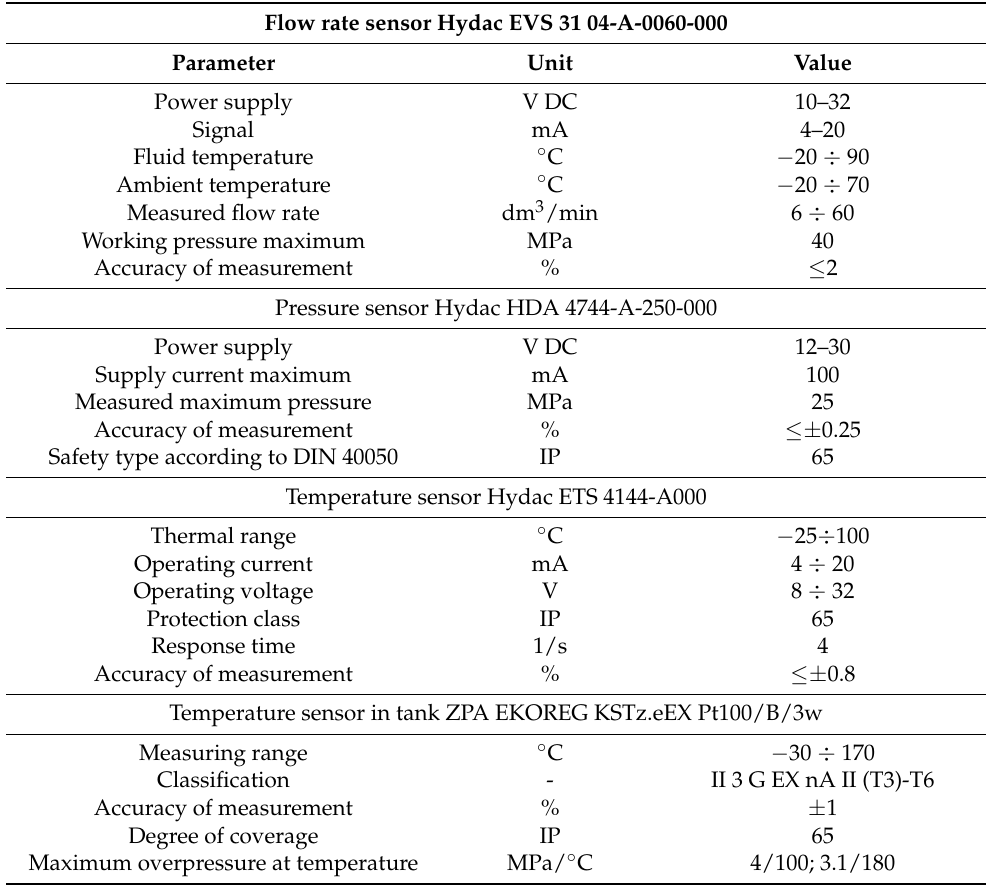
Table 1. Basic data of volumetric flow rate, pressure, and temperature sensor